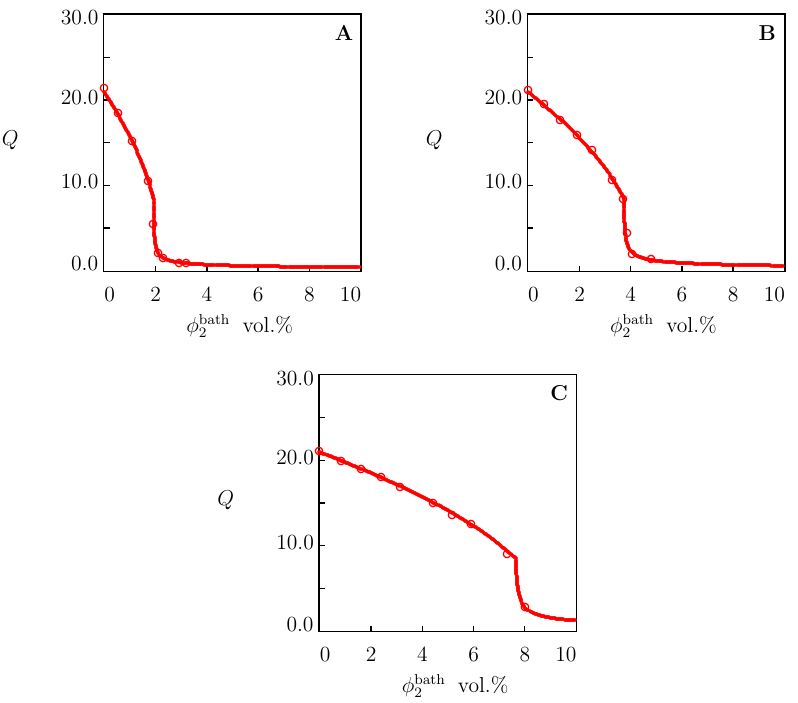
Figure 3. Equilibrium degree of swelling Q versus concentration of salts in aqueous solutions φ bath Circles: experimental data on PNIPAAm gel [38] in aqueous solutions of NaCl ( A ), NaBr ( B ) and NaI ( C ) at temperature T = 25 ◦ C. Solid lines: predictions of the